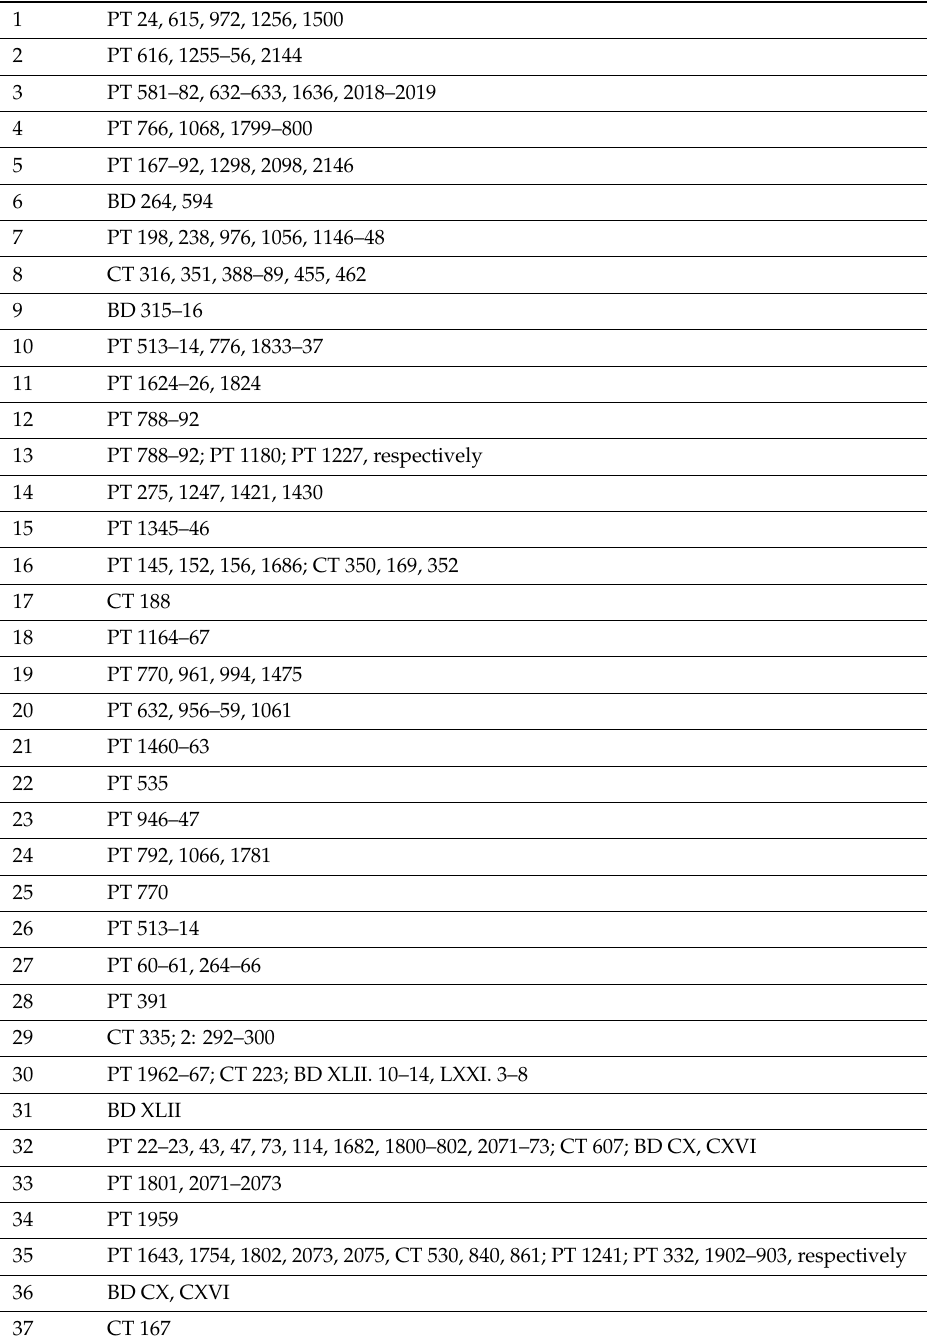
Table 1. Citations from Egyptian Heiroglyphic Inscriptions. PT = Pyramid Texts (Faulkner 1969); CT = Coffin Texts (Faulkner 2004); BD = Book of the Dead (Budge [ 1899 ]